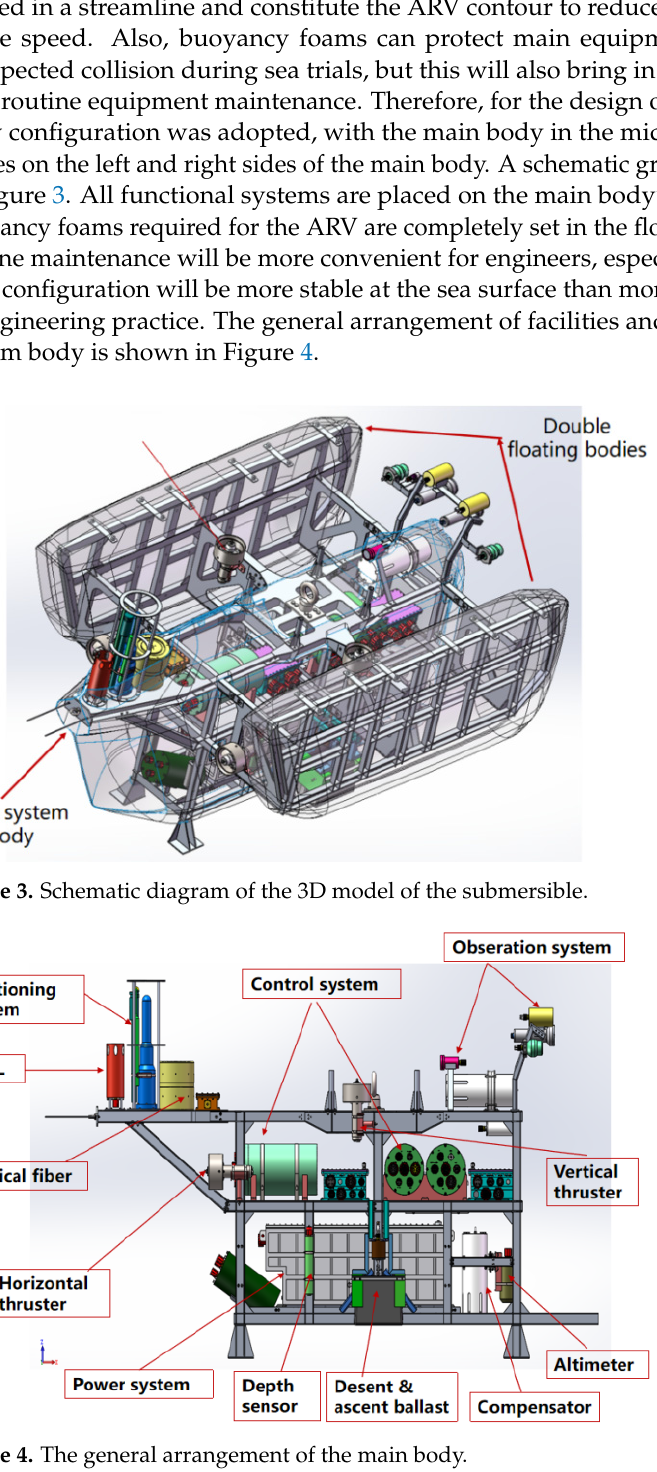
Figure 4. The general arrangement of the main